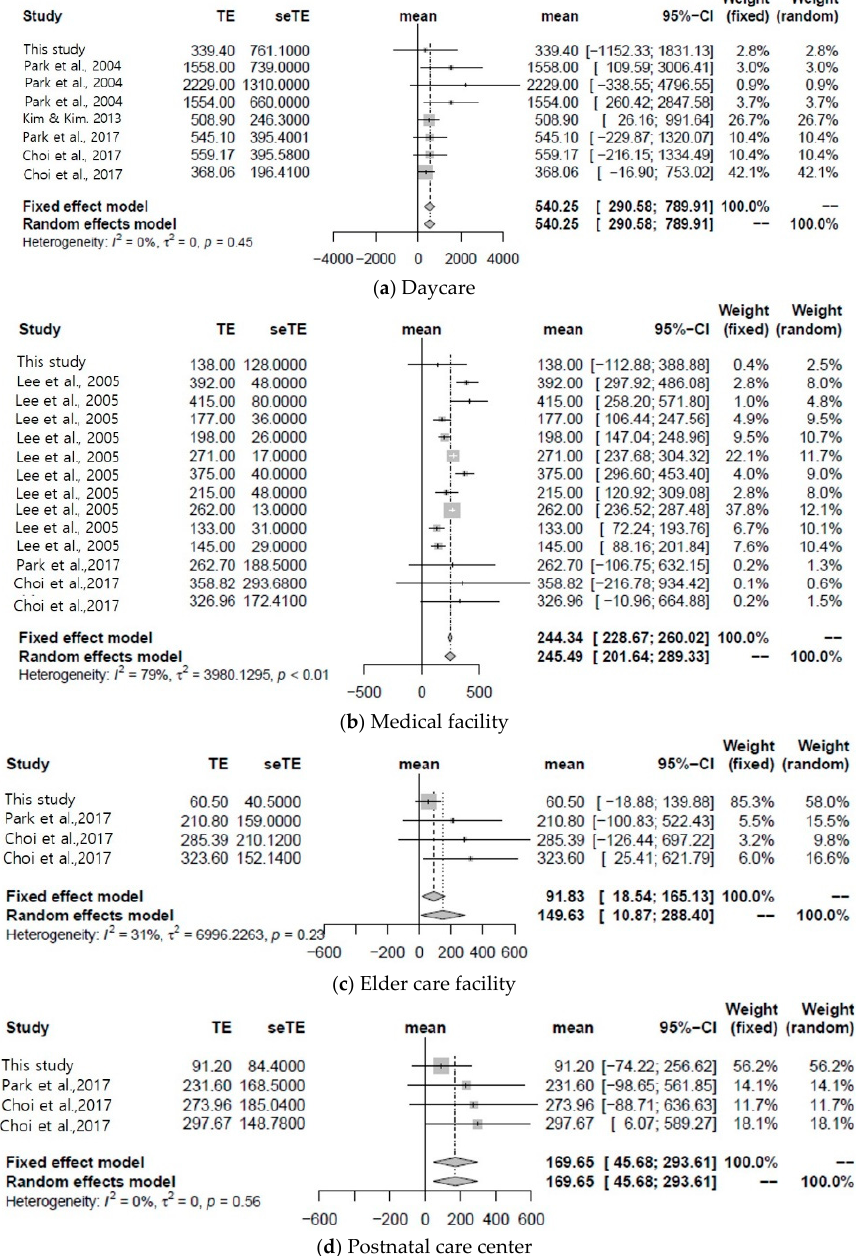
Figure 2. Pooled average concentration of airborne bacteria in each facility (daycare, medical facility, elder care facility, postnatal care center).